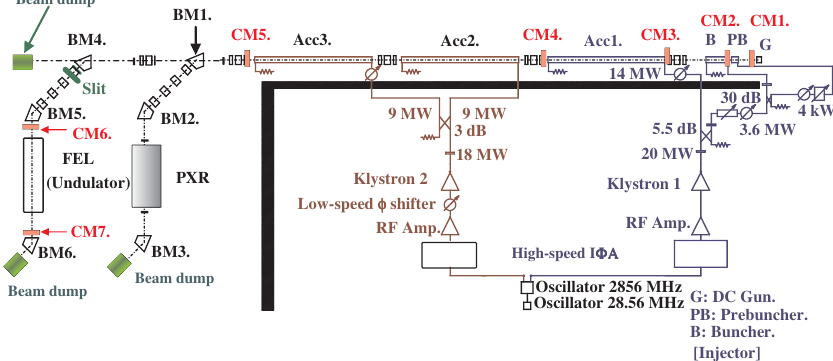
FIG. 8. (Color) Layout of the 125 MeV electron linac at LEBRA.